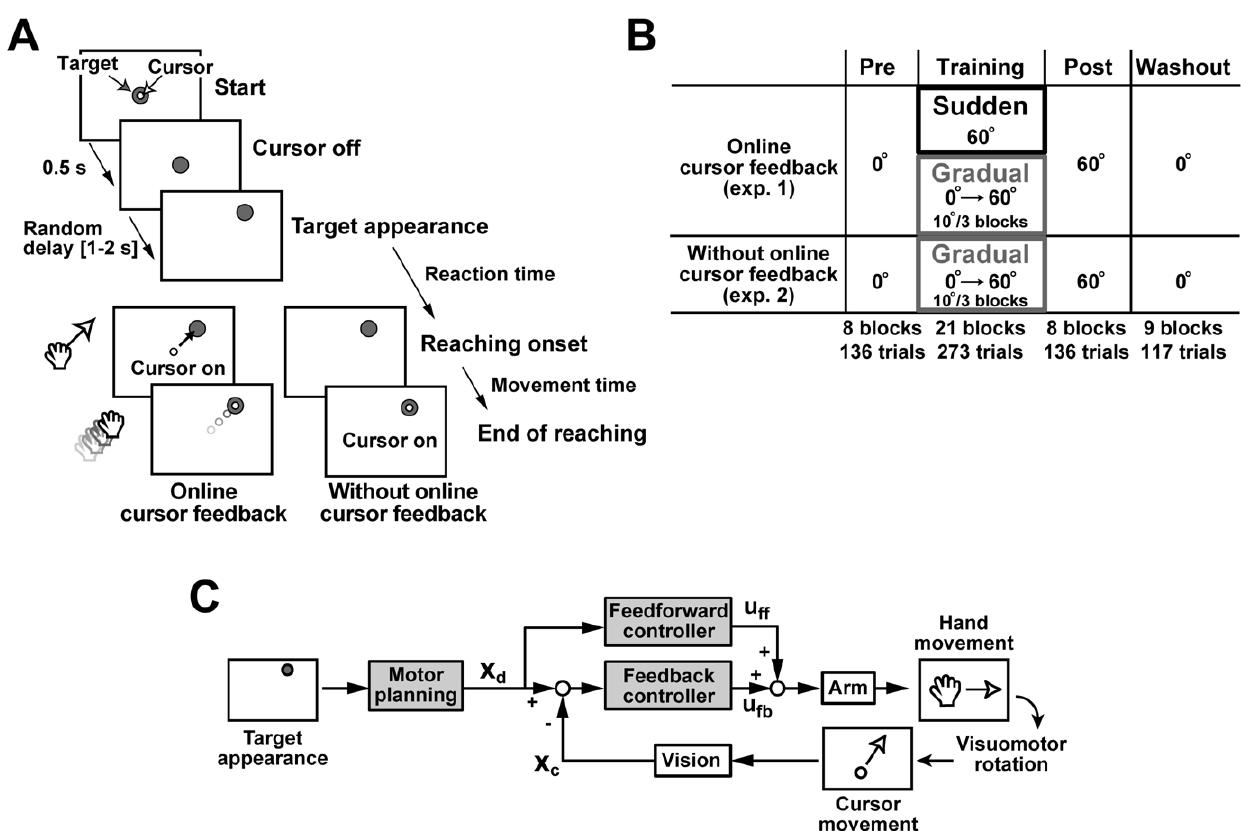
Figure 1. Experimental procedure and computational scheme for visually guided reaching. A , Time sequence of one trial. There were two conditions: reaching with and without online cursor feedback. See Materials and Methods for details. B , Total trial procedure. The angles are the visuomotor rotation angles. Each experiment consisted of four phases: pre-training, training, post-training, and washout phases. The cursor online feedback was shown in experiment 1 but not in experiment 2. In experiment 1, subjects were divided into two groups and the visuomotor rotation was suddenly or gradually introduced in the training phase for each group. The 60 u CCW visuomotor rotation was continued in the post-training phase and then suddenly changed to 0 u in the washout phase. C , Computational scheme for visually guided reaching, where x d represents desired movement of the arm, x c indicates feedback information of current movement, and u ff and u fb indicate feedforward and feedback motor commands, respectively. This scheme assumes that target presentation triggers the motor planning and that the feedforward controller transforms the desired movement into motor commands. The manipulandum system converts the hand movement into cursor movement in the rotationally biased direction on the screen. The feedback controller adjusts the ongoing movement using the feedback information of the cursor